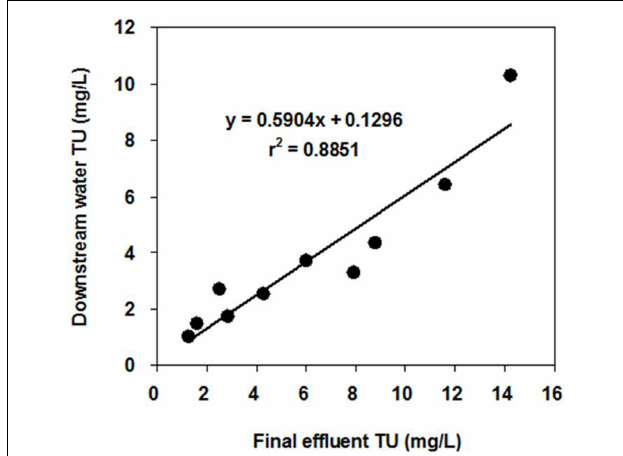
FIGURE 3 | Correlation between the toxicity of the final effluent (FE) and the toxicity of the downstream water (DS). The error bars represent 95% confidence